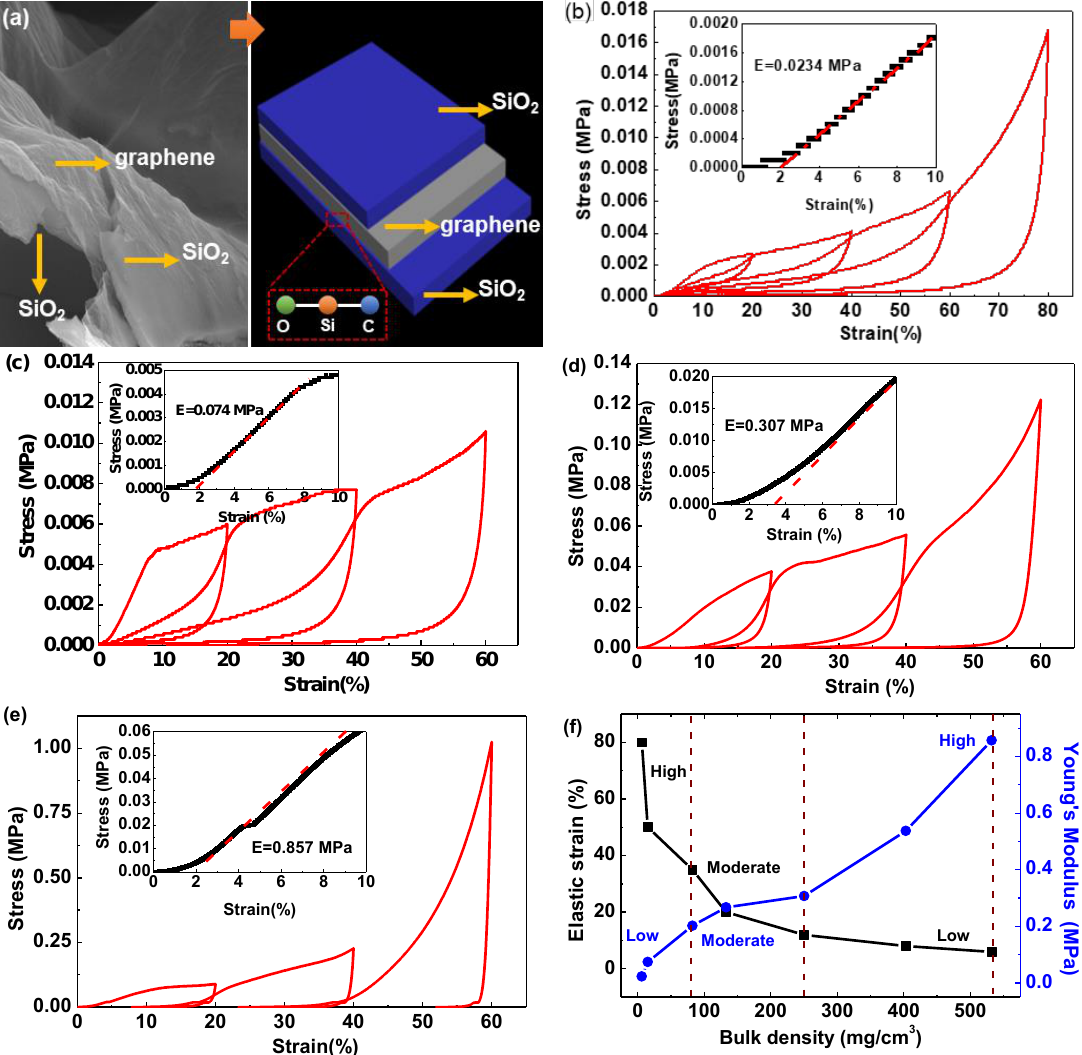
Figure 8. Mechanical properties of GSAs under compression deformation. ( a ) Graphene and SiO 2 -composited multilayer structure: ( b ) GSA-0, ( c ) GSA-1, ( d ) GSA-20, ( e ) GSA-40; and ( f ) impact of GSA bulk densities on elastic strain and Young’s modulus.